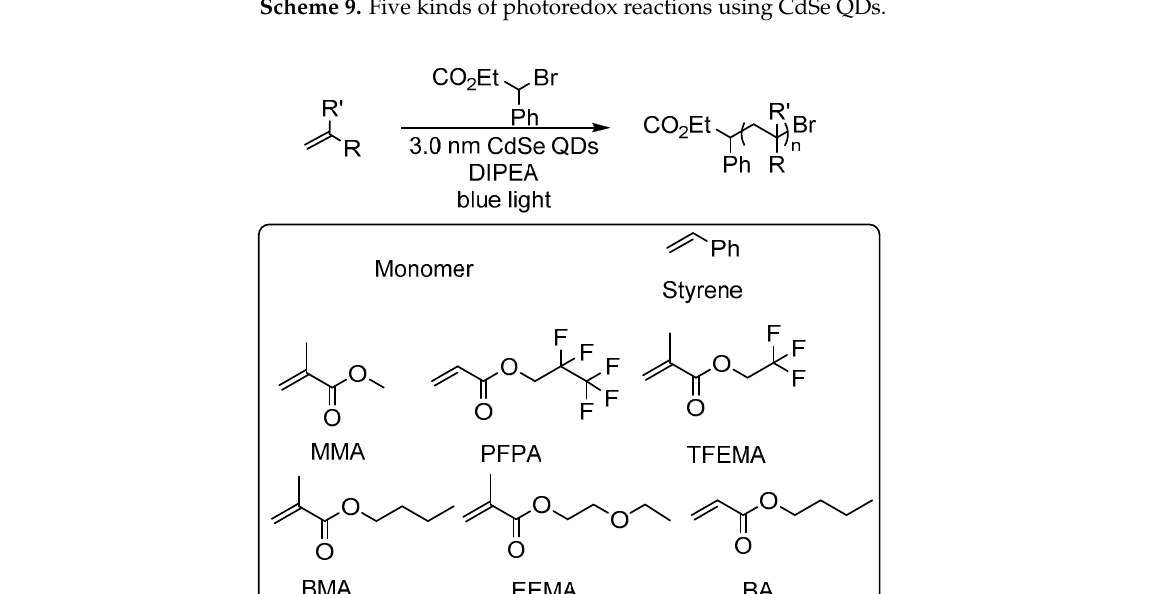
Scheme 9. Five kinds of photoredox reactions using CdSe QDs.